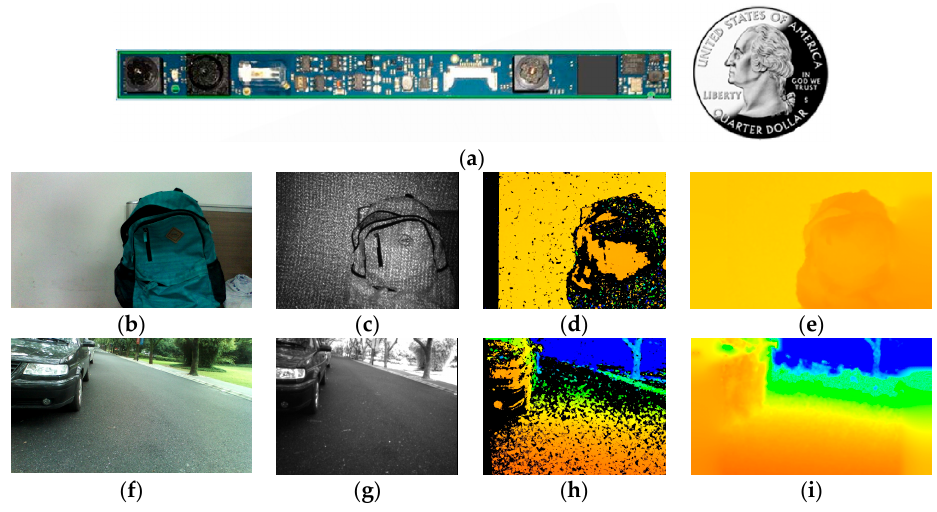
Figure 1. ( a ) The RealSense R200; ( b , f ) color image captured by the RealSense R200; ( c , g ) IR image captured by the right IR camera of the RealSense R200; ( d , h ) the original depth image from the RealSense R200; and ( e , i ) the guided filtered depth image acquired in our work.